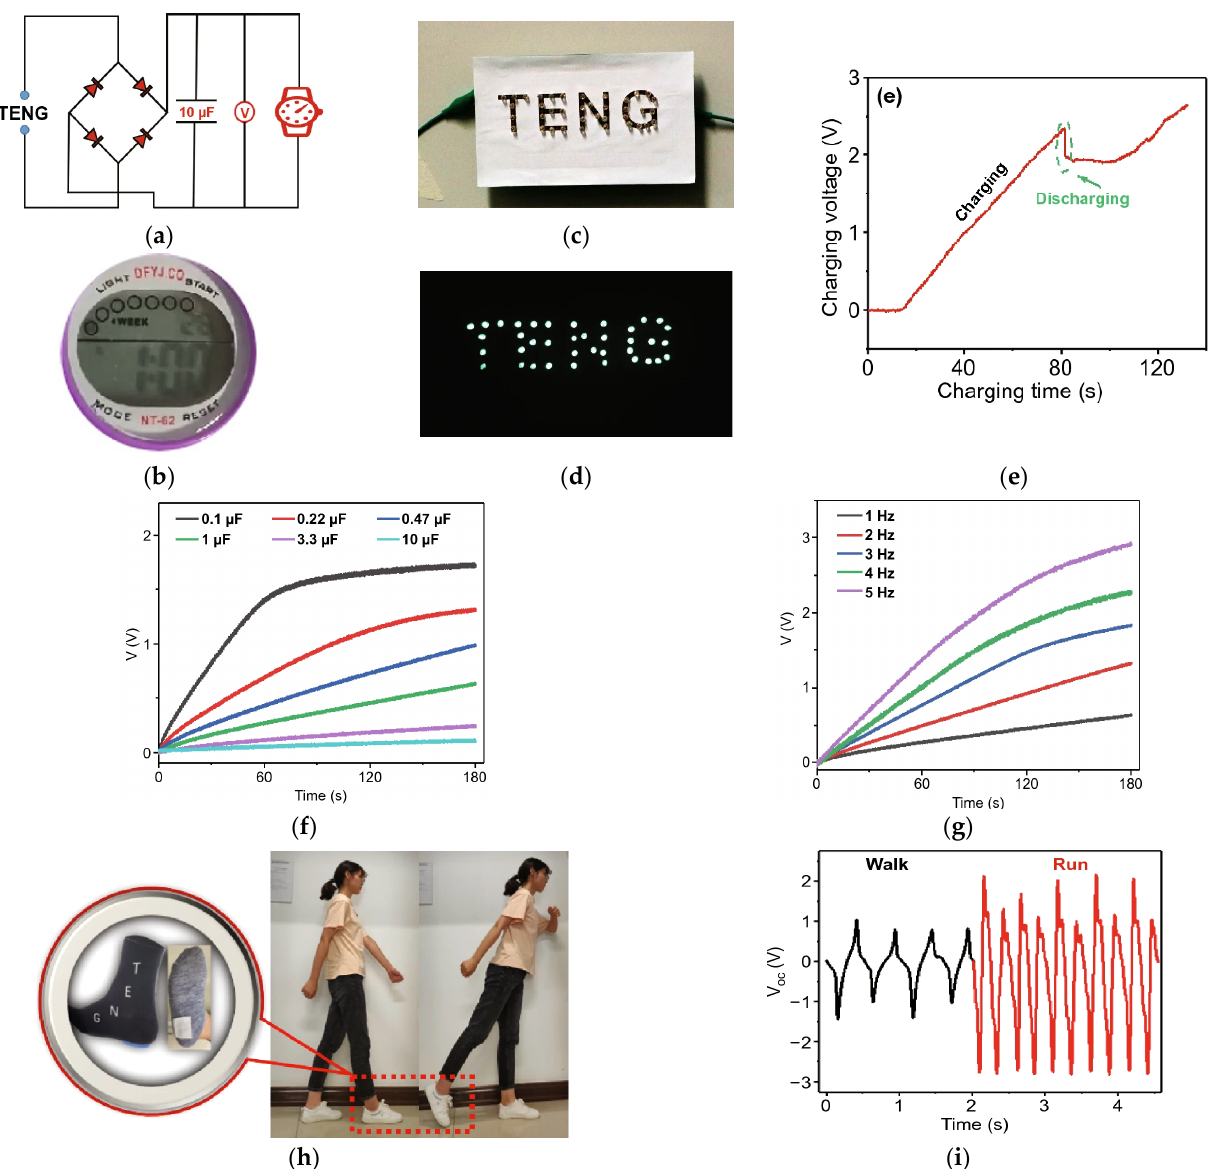
Figure 5. F-TENG’s energy harvesting capability. Schematic of conditioning system used for the F-TENG ( a ) to feed a commercial watch ( b ); representations of how to light up various LED modules with a single F-TENG ( c , d ); charge-time dependent F-TENG charging voltage ( e ). Graphs reporting the F-TENG charging ability with storage capacitance from 1 µF to 10 µF ( f ) and striking frequencies from 1 Hz to 5 Hz ( g ). The F-TENG is inserted into a sock ( h ) to create a pedometer system, and the output voltage is related ( i ) [77].